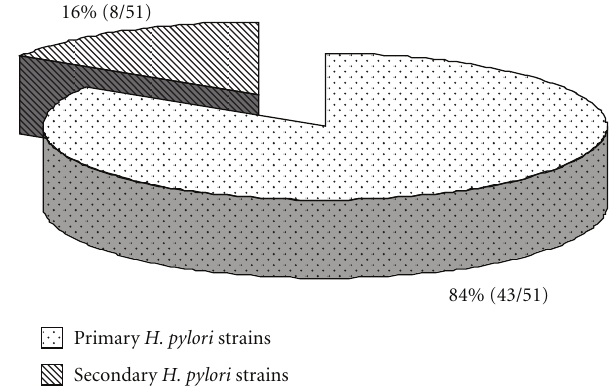
Figure 2: The percentage of primary and secondary H. pylori strains isolated from dyspeptic patients enrolled in the study in 2009–2011.